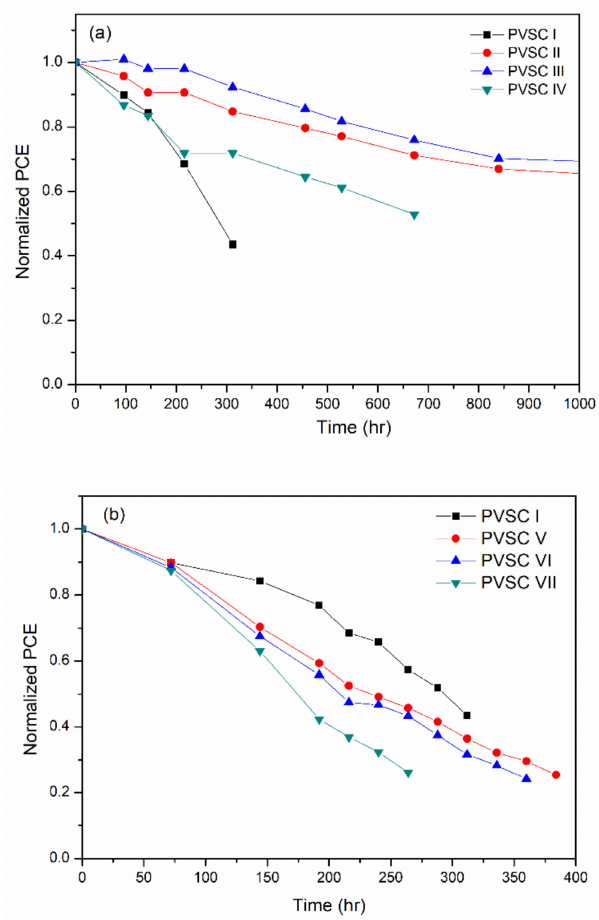
Figure 12. Storage-stability of PVSCs incorporating BCP, BCP/PMMA, and BCP/PVP films (( a ) BCP (PVSC I), BCP/PMMA (PVSC II-IV); ( b ) BCP/PVP (PVSC V-VII); measured at 30 ◦ C and 35% relative